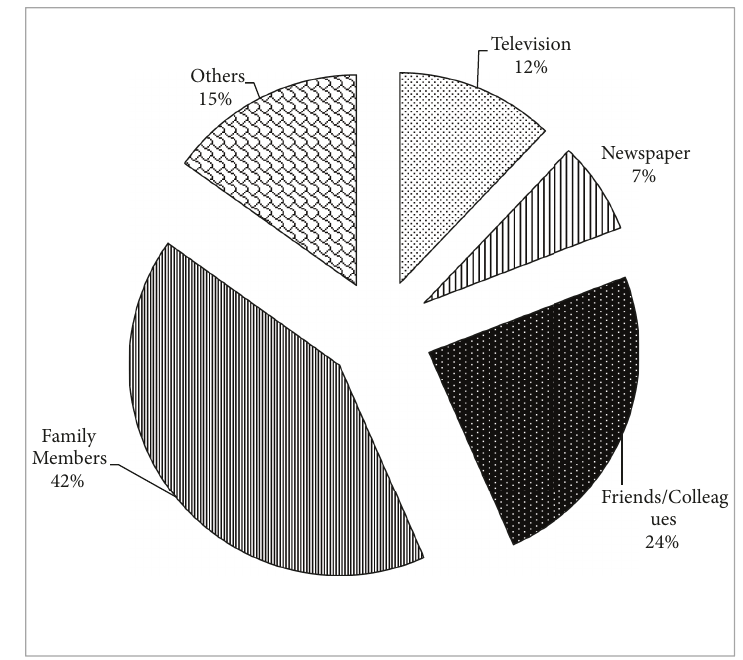
Figure 3: Source of information/awareness about functional foods.